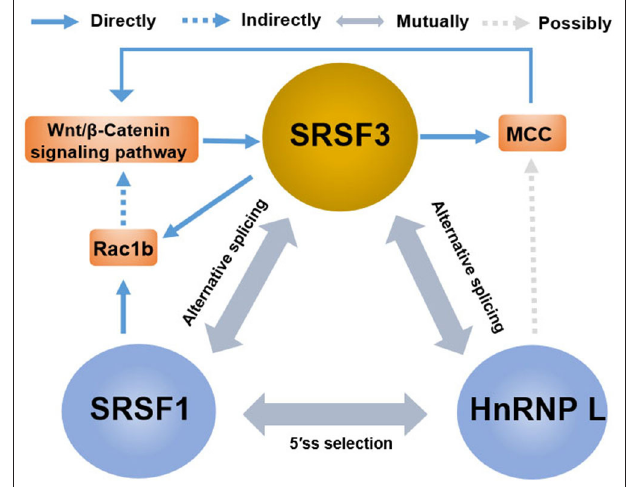
FIGURE 6 | The crosstalk between SRSF3 and other splicing regulators in the regulation of gene expression. There are antagonistic effects among SRSF3, SRSF1, and HnRNP L on alternative splicing or 5’ss selection, involving the key genes or signaling pathways, such as the Wnt/ β -catenin pathway, MCC protein, and